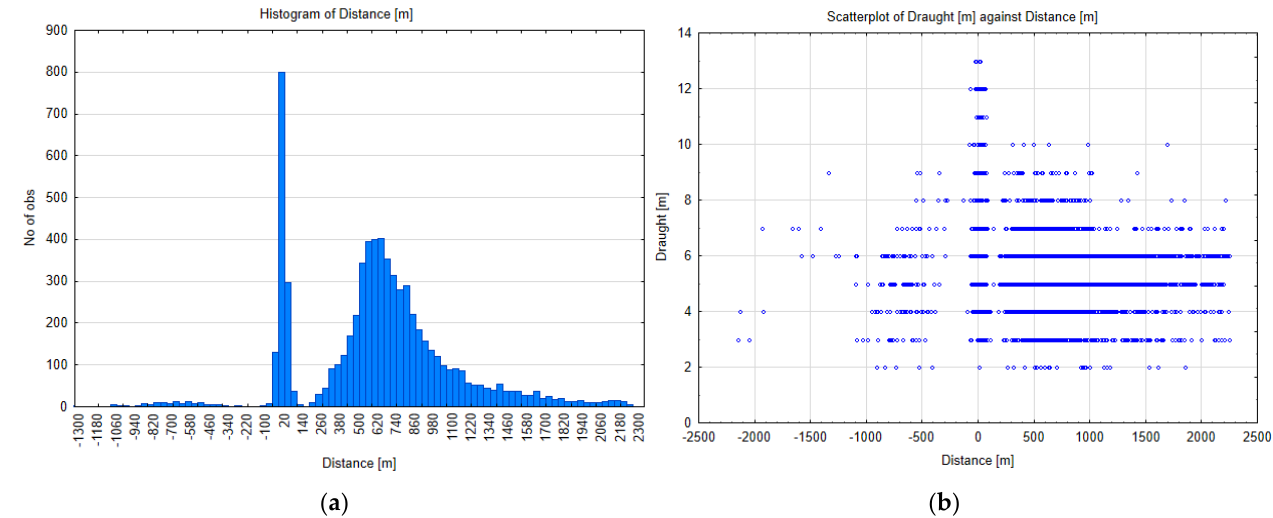
Figure 3. ( a ) Spatial distribution of ship’s position relative to track axis at leg N4, incoming traffic; ( b ) scatterplot of ships draught versus distance from centre.